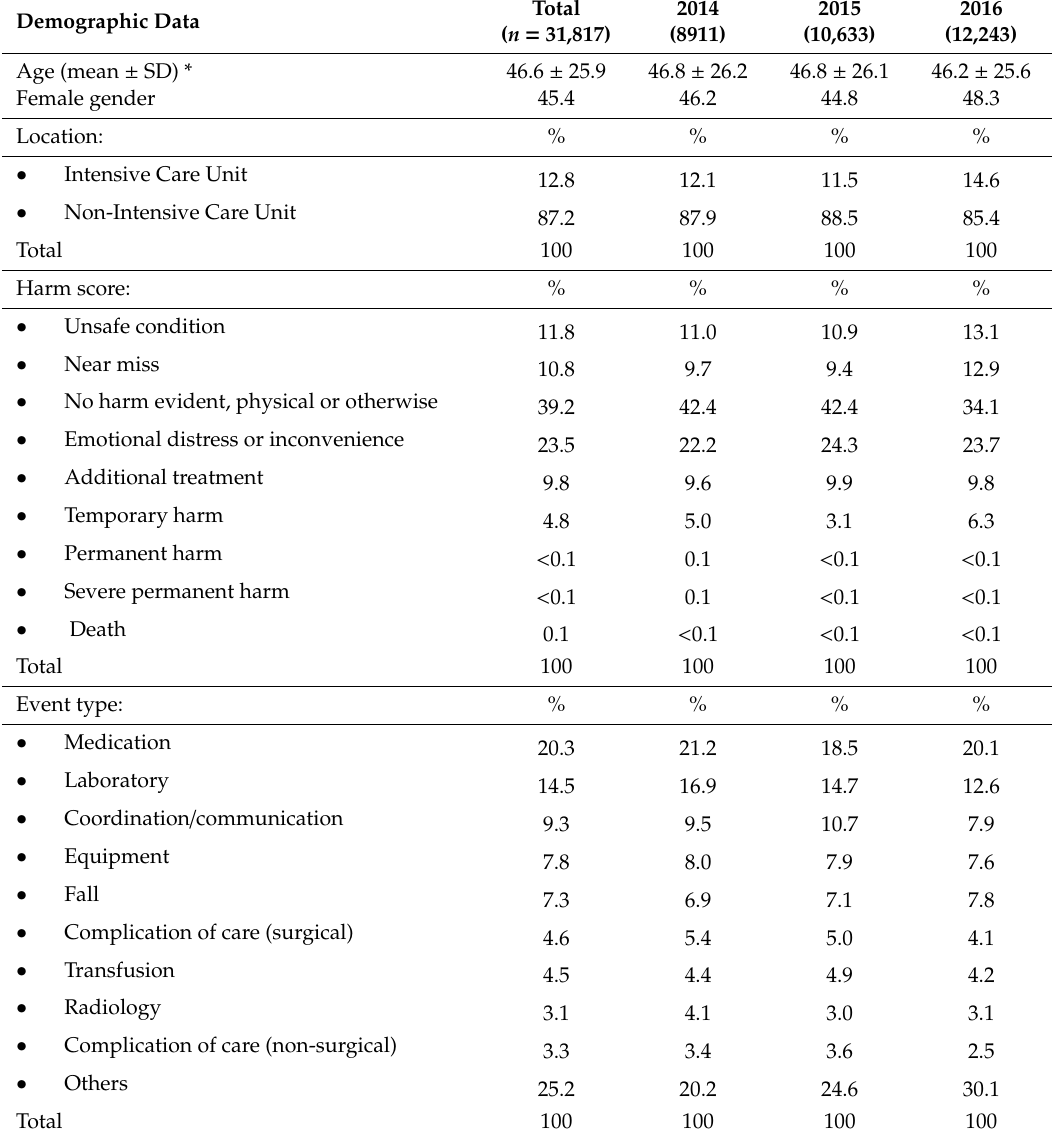
Table 3. Descriptive epidemiology of safety